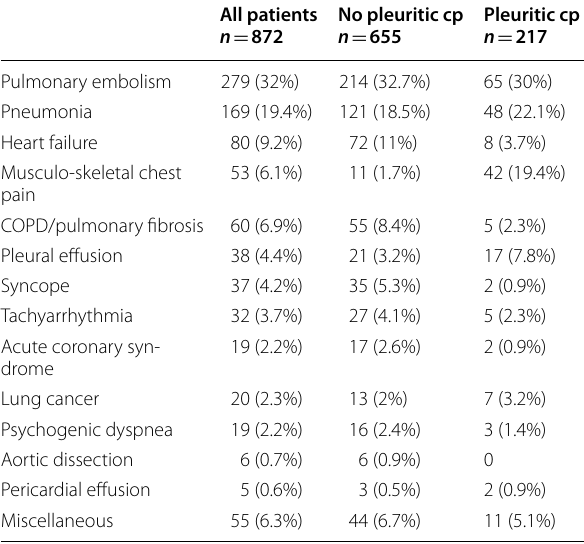
Table 2 Final diagnoses in all patients and in patients with and without pleuritic chest pain at